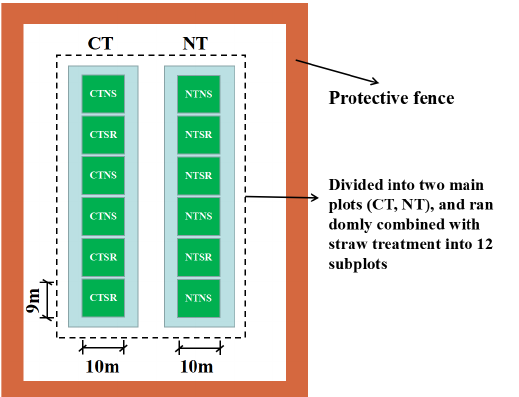
Figure 2. Design drawing of field experiment. Note: CT, conventional tillage; NT, no tillage; CTNS, conventional intensive tillage with straw removal; CTSR, conventional intensive tillage with straw return; NTNS, no tillage with straw removal; NTSR, no-tillage with straw return. For all treatments, weeds were controlled by spraying 30% chlorpromazine emulsi- fiable oil containing 10% fenorim. The application rate of chemical fertilizer was 180 kg N ha −1 , 90 kg P 2 O 5 ha −1 and 180 kg K 2 O ha −1 in rice season and was 144 kg N ha −1 , 72 kg P 2 O 5 ha −1 , and 144 kg K 2 O ha −1 in wheat season. Commercial compound fertilizer (N: P 2 O 5 : K 2 O = 15%:15%:15%) were used in rice and wheat seasons. P and K fertilizers were